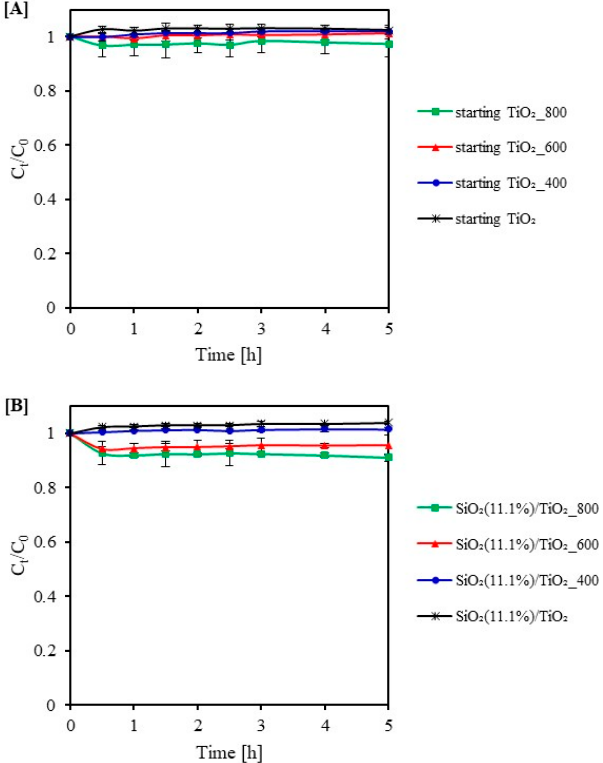
Figure 7. Adsorption of methylene blue on the surface of starting TiO 2 and reference materials ( A ) and fumed silica-modified TiO 2 prior and after heat treatment ( B ). ( A ) and fumed silica-modified TiO 2 prior and after heat treatment ( B